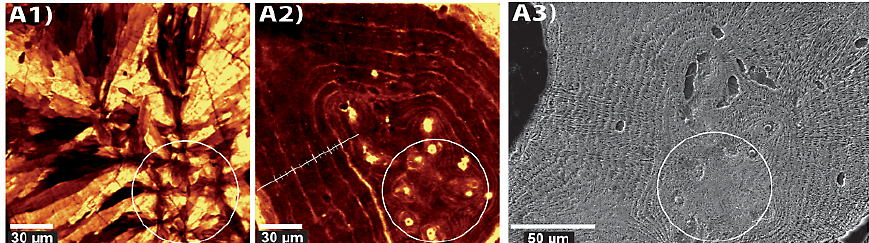
Fig. 5. Transversal cross section of the skeleton of P. lutea . Map obtained from the Raman intensity distribution of the symmetric stretch of aragonite (1085cm − 1 ), (A1) and fluorescence intensity distribution (A2) . (A3) A SEM micrograph obtained after Raman mapping and etching of the sample. Circle in the images illustrates the same area within the different maps. The scale bar within the fluorescence map displays the skeletal extension for each growth cycle comprised of one high and one low fluorescence growth line.